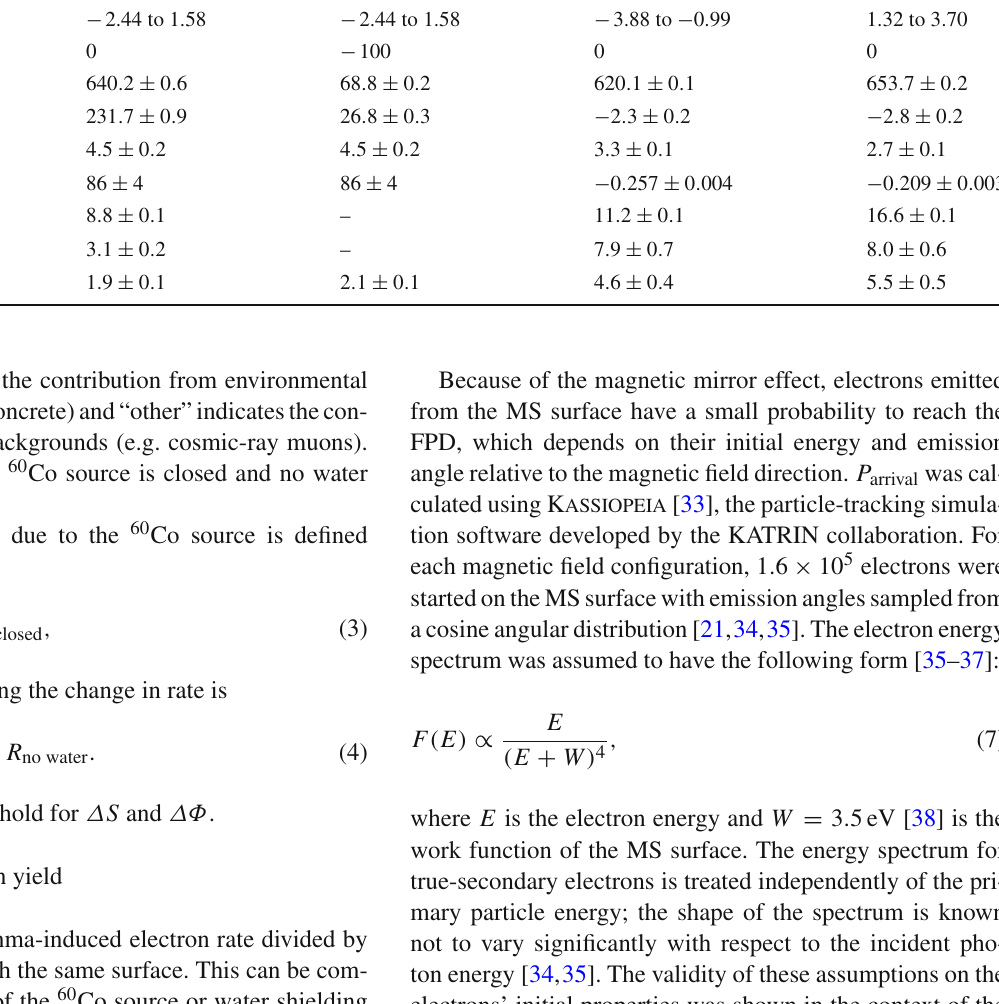
of the spectrometer surface are measured for each setting), and these values also differ from the values given in Table 5 (since the latter considered the entire spectrometer